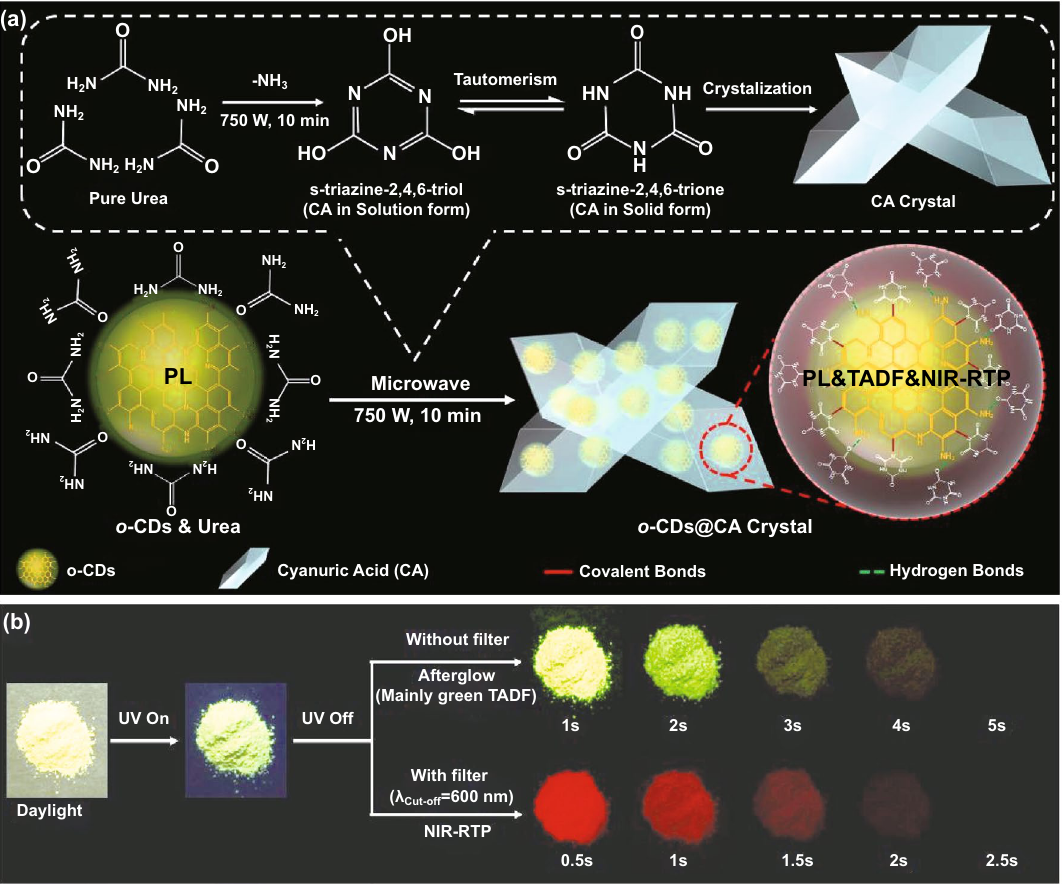
Fig. 1 a Schematic illustration for the synthesis of CA from urea, in situ embedding and fixing o-CDs into CA matrix, and possible structures of o-CDs@CA; b images of the o-CDs@CA powder under daylight, 365 nm UV irradiation, afterglows without and with an optical filter (cut-off wavelength (λ Cut-off ) of 600 nm) being